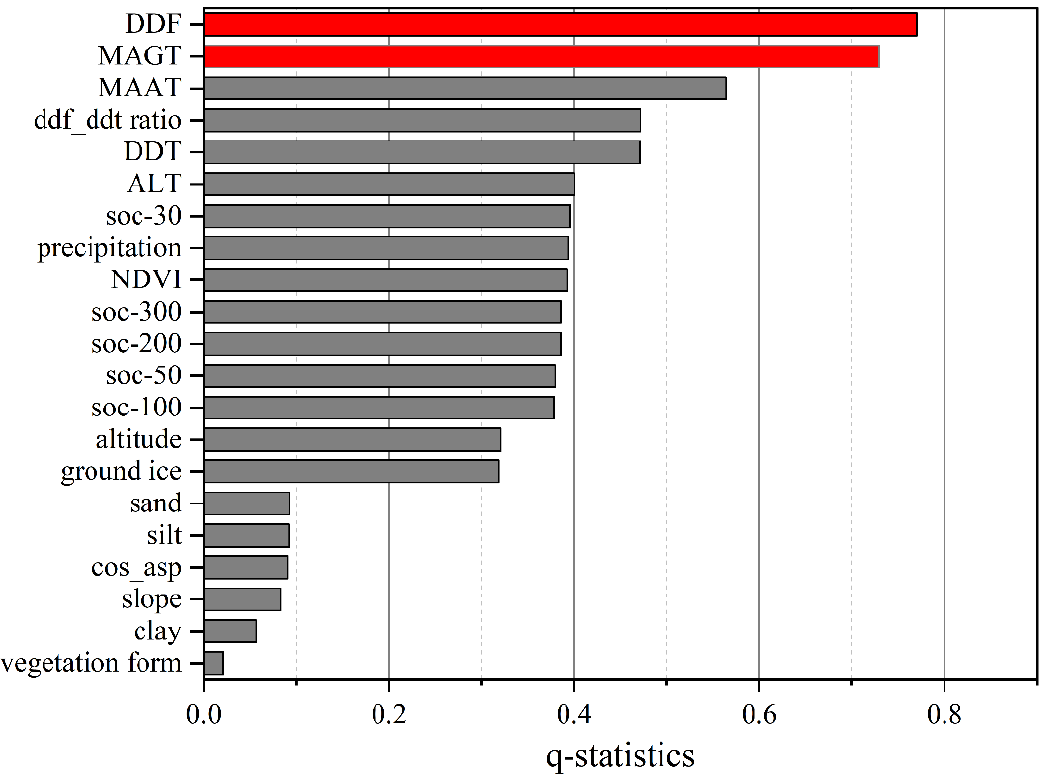
Figure 9. The q-statistic of environmental factors in controlling the amplitude of seasonal deformation (the red bars are greater than 0.6).